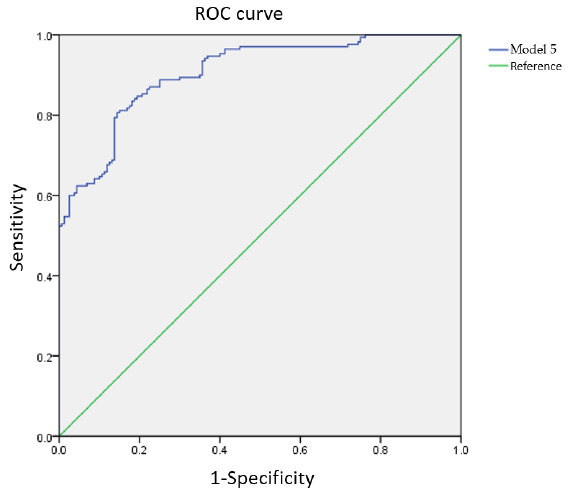
Table 4. Model 5 confusion matrix for the validation group.